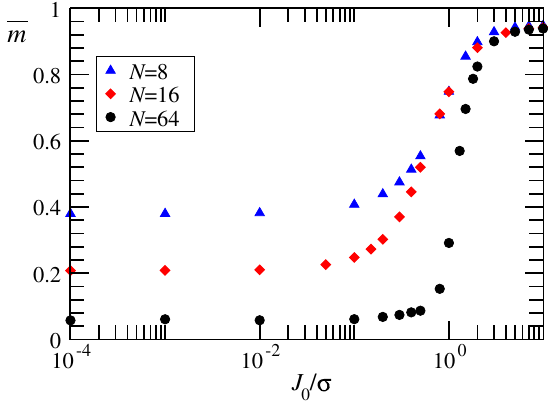
FIG. 7. The time-averaged magnetization versus the control parameter x ¼ J 0 = σ . The transition at x ≈ 1 becomes more abrupt as N increases. In these simulations, the initial preparation was taken to have averaged energy density h ≈ 0 . 88 ϵ 1 (low-energy regime; ϵ 1 is the smallest eigenvalue of the corresponding linear system) while the nonlinearity is χ ¼ 0 . 01